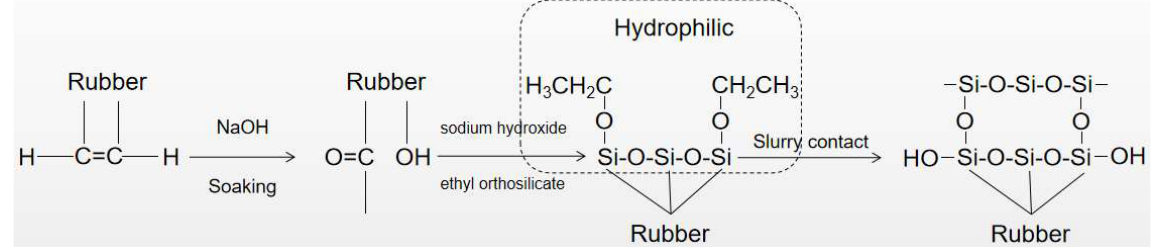
Figure 12. Schematic diagram of chemical modification of rubber surface and contact with cement paste.